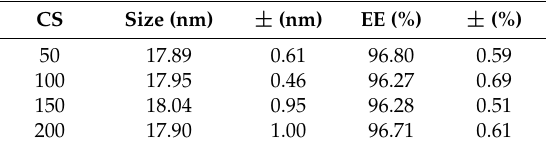
Table 1. Mean size of the nanoliposome and encapsulation efficiency (EE) as a function of quantity of CS.